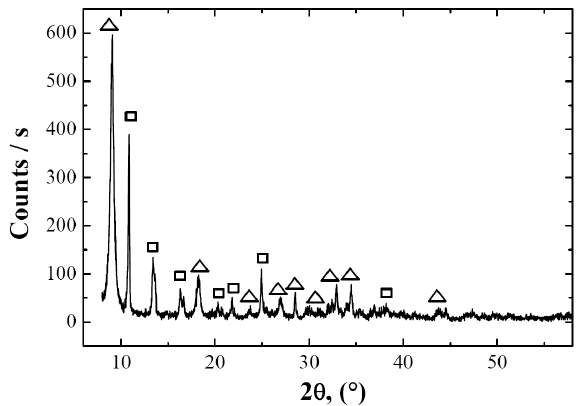
Figure 5 . The X-ray patern of a sample prepared in 45 mL of 0.5 M Zn(NO ) •6H O solution,. Δ Zn 3 2 2 Working power – 7 W, distance between the nozzle and solution level – 7